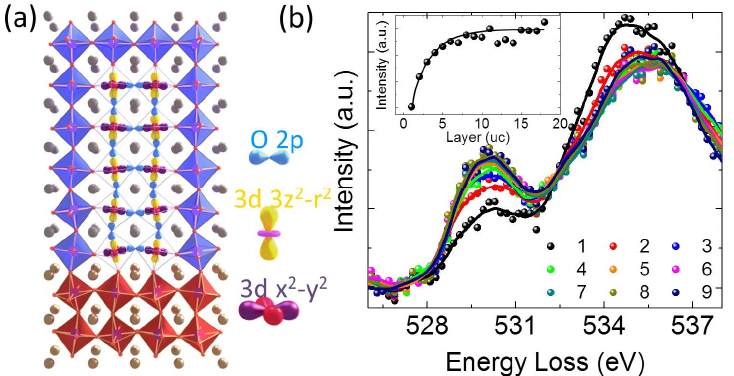
Figure 12. ( a ) Schematic view of the evolution of the overlap of Mn-3d orbital with O-2p orbitals across the interface in the oxide heterostructure. ( b ) Detailed O-K edge spectra of individual layers atomically-resolved electron energy loss spectra (EELS) mapping for a 30 u.c. LSMO film on NGO substrate. Reproduced with permission from Liao et al. [40]. Copyright 2017 John Wiley and